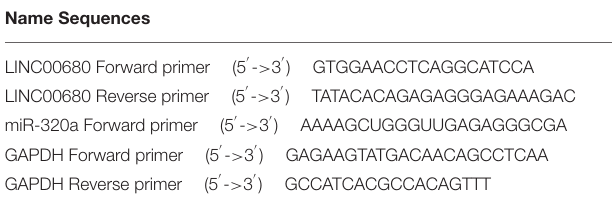
TABLE 1 | Characteristics of patients with myasthenia gravis (MG) and healthy controls.